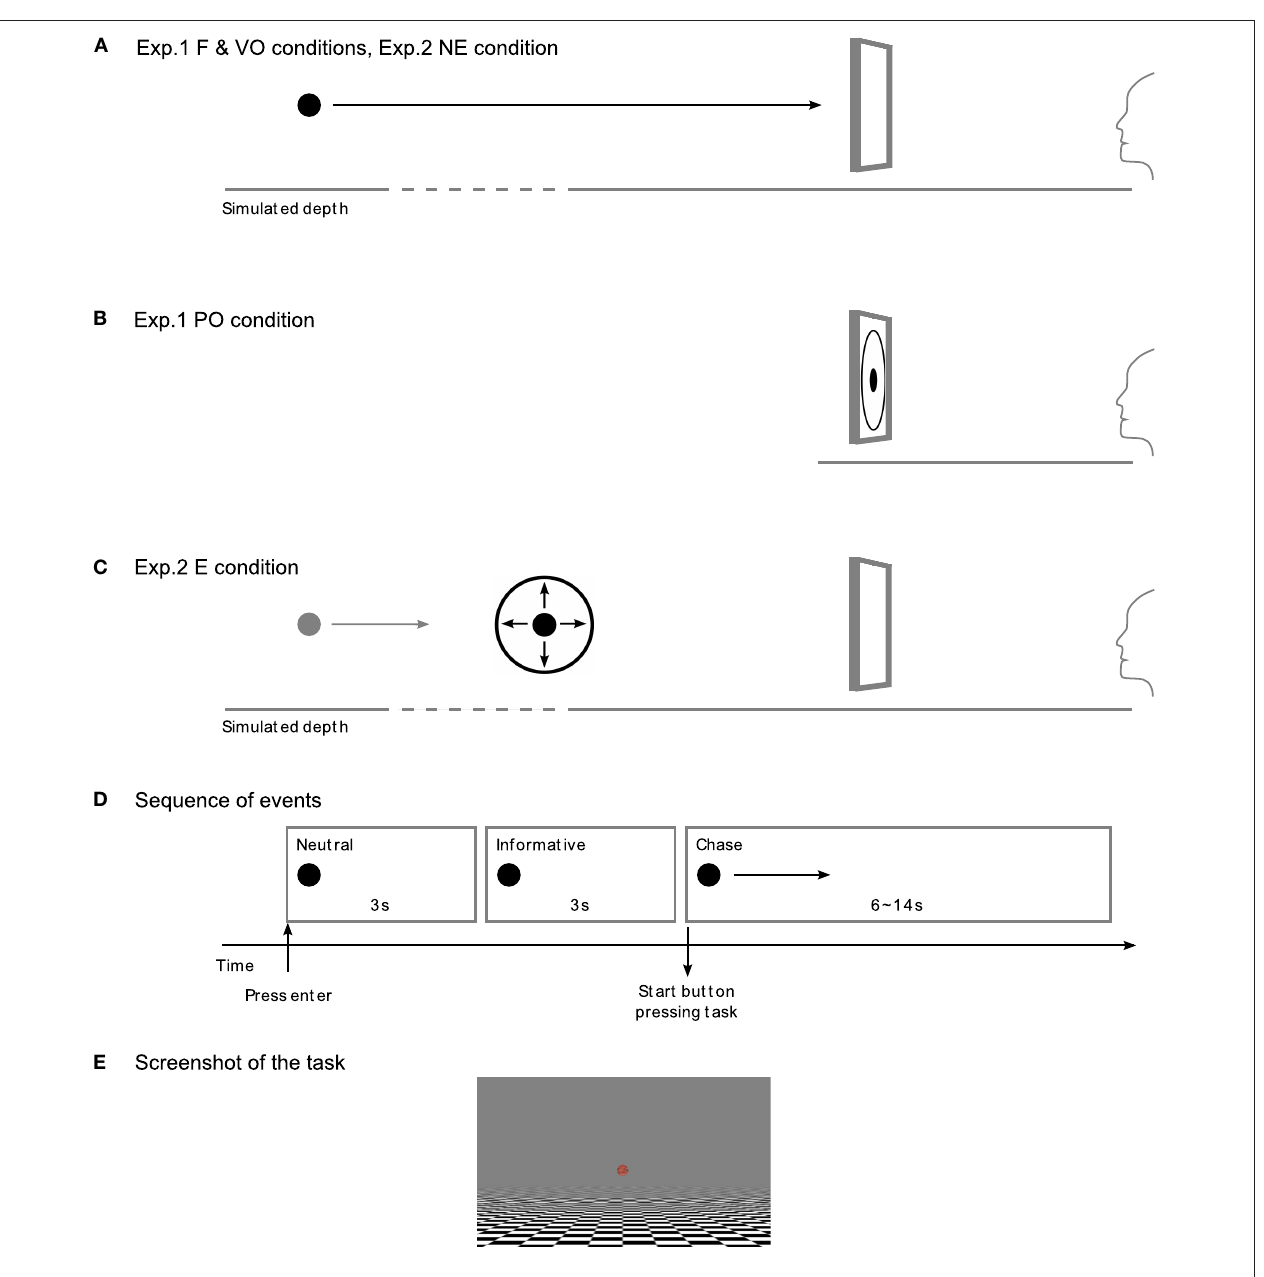
FigurE 1 | Schematic representation of the experimental conditions and sequence of events in the trial. In the F and VO conditions of experiment 1 and the NE condition of experiment 2, the predator appeared behind the screen, i.e., at a simulated depth (A) . In the PO condition of experiment 1, the predator appeared constantly on the screen plane (B) . In the E condition of experiment 2, the predator, which appeared in depth,